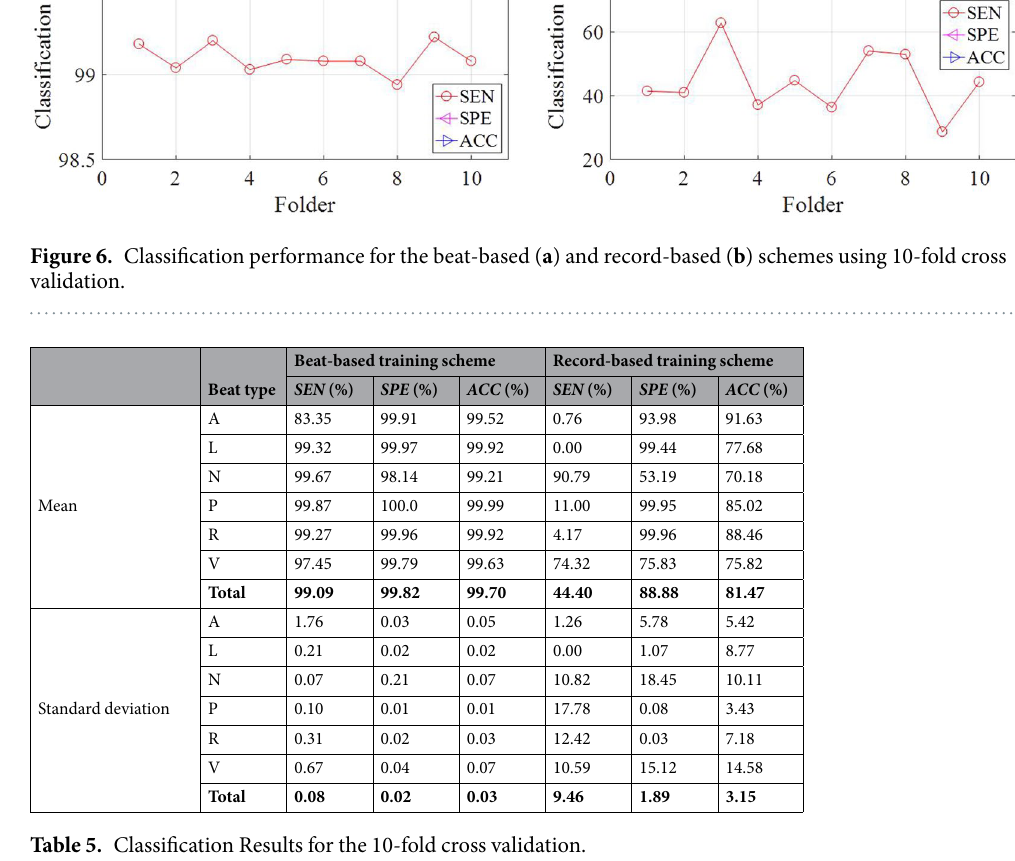
Table 5. Classification Results for the 10-fold cross